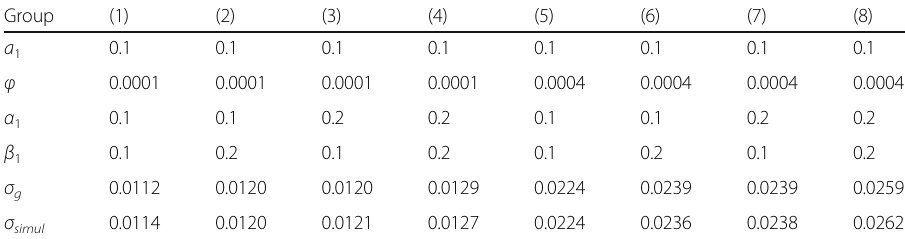
Table 3 Results on risk for the AR (1)-GARCH (1,1) process. The table reports the actual standard deviations of the simulated returns and their theoretical values for eight AR (1)-GARCH (1,1) processes with different parameters. The actual standard deviation of the simulated returns is denoted by σ simul , and its theoretical value is denoted by σ g